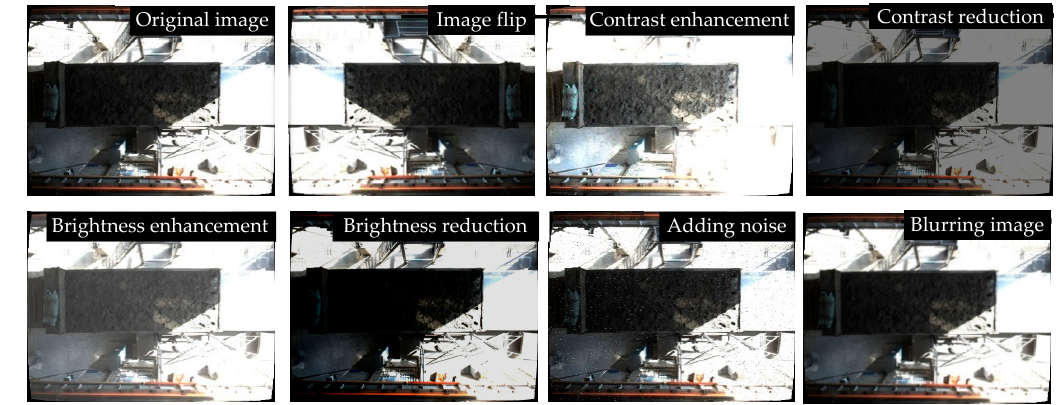
Figure 11. Data augmentation renderings.